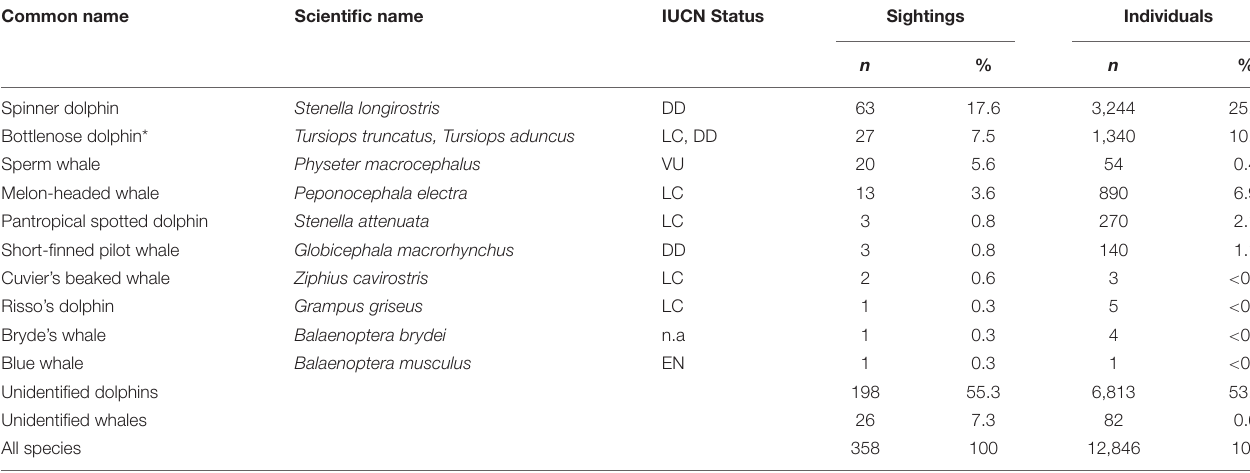
TABLE 2 | Summary of cetacean species sighted in Wakatobi and relative number of sightings and individuals (in relation to total n ) from May 2004 to May